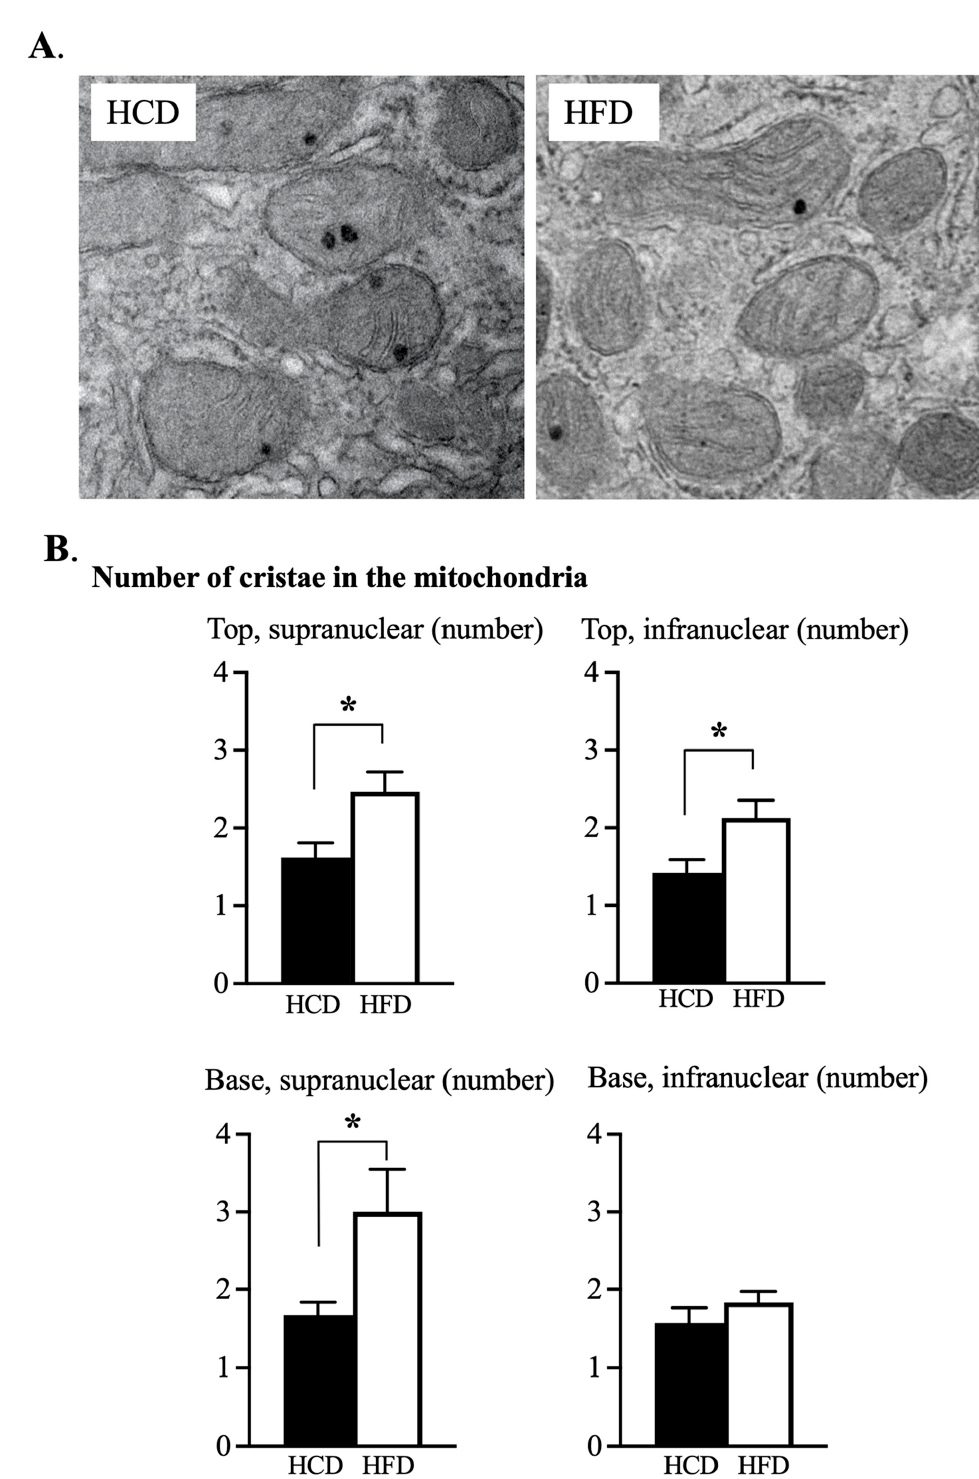
Figure 5. ( A ). Shows two examples of mitochondria from the same participant at a magnification × 31,500 after ingestion of HCD and HFD over 2 weeks. ( B ). The number of cristae in the mitochondria: Note that ingestion of the HFD compared to HCD increased the number of cristae in the top region ( p = 0.01 and p = 0.02 respective), as well in the base supranuclear part ( p = 0.03) of the enterocyte. Electron microscopy: × 31,500, n = 6, * p ≤ 0.05 Wilcoxon signed-rank